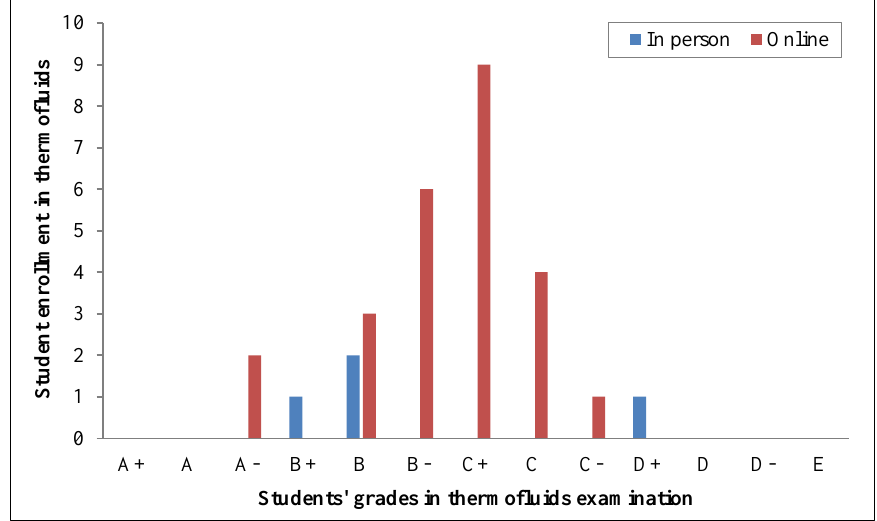
Figure 8. Grade distribution in Advanced Thermofluids course in virtual and in-person learning